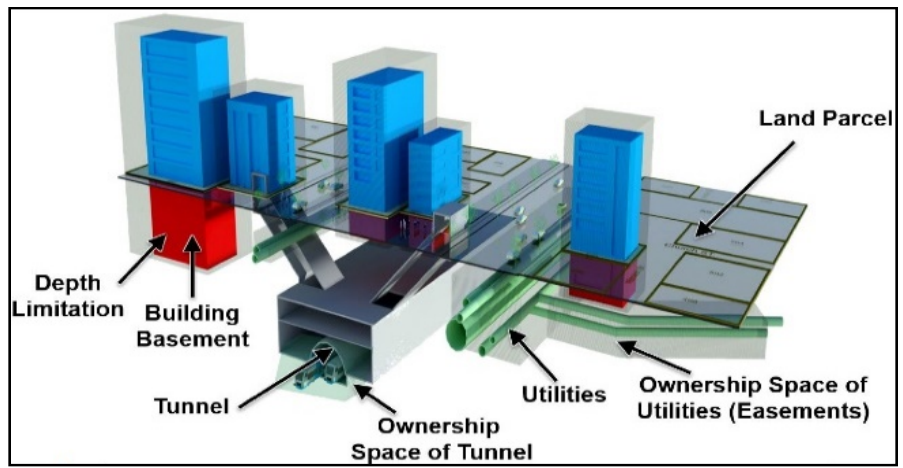
Figure 2. A 3D underground model integrating physical and legal data as an appropriate solution for underground land administration.